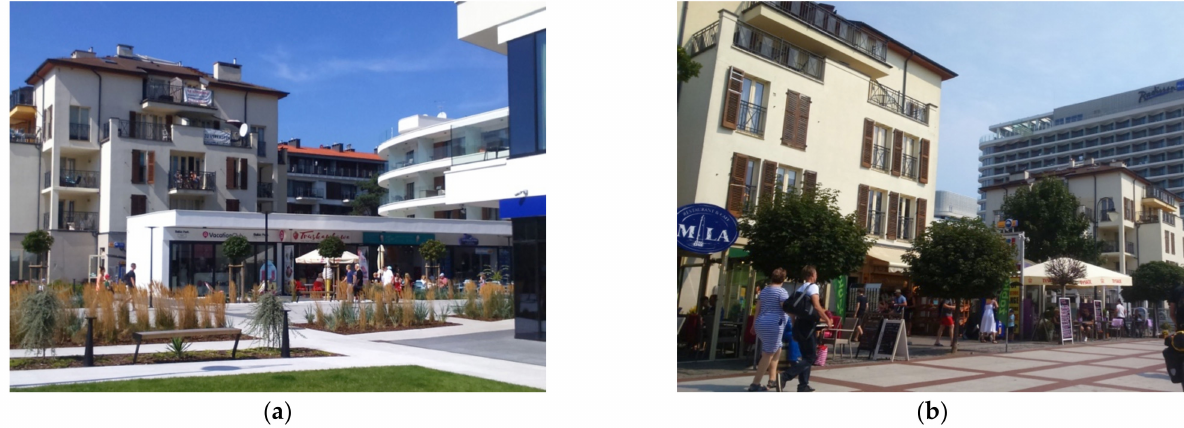
Figure 8. ´Swinouj´scie, Baltic Park Promenada ( a , b ). Source: Author’s photo ( a , b